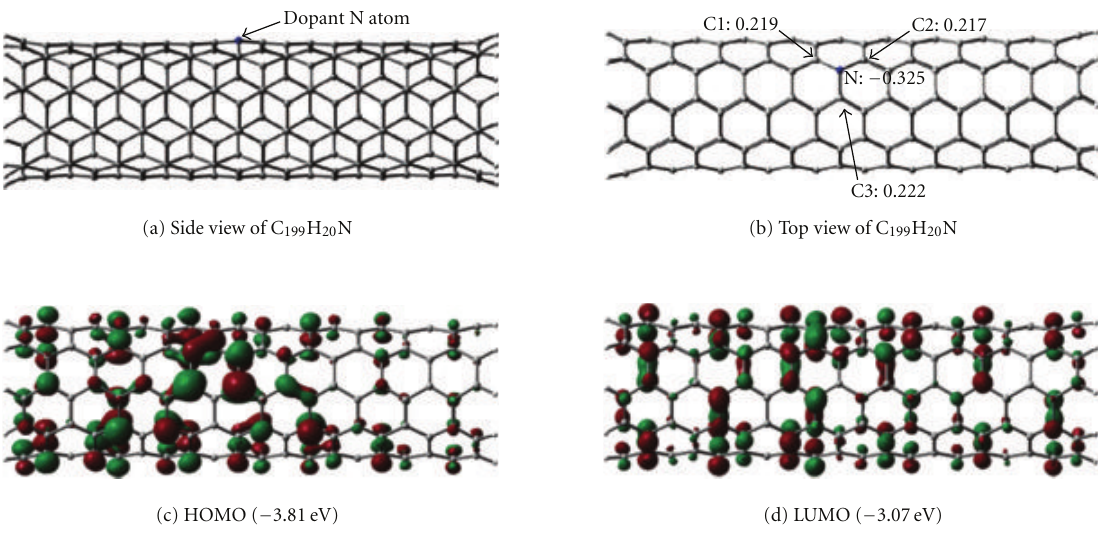
Figure 8: Optimized geometry and FMOs of C 199 H 20 N. Orbital energies are in parentheses [81].